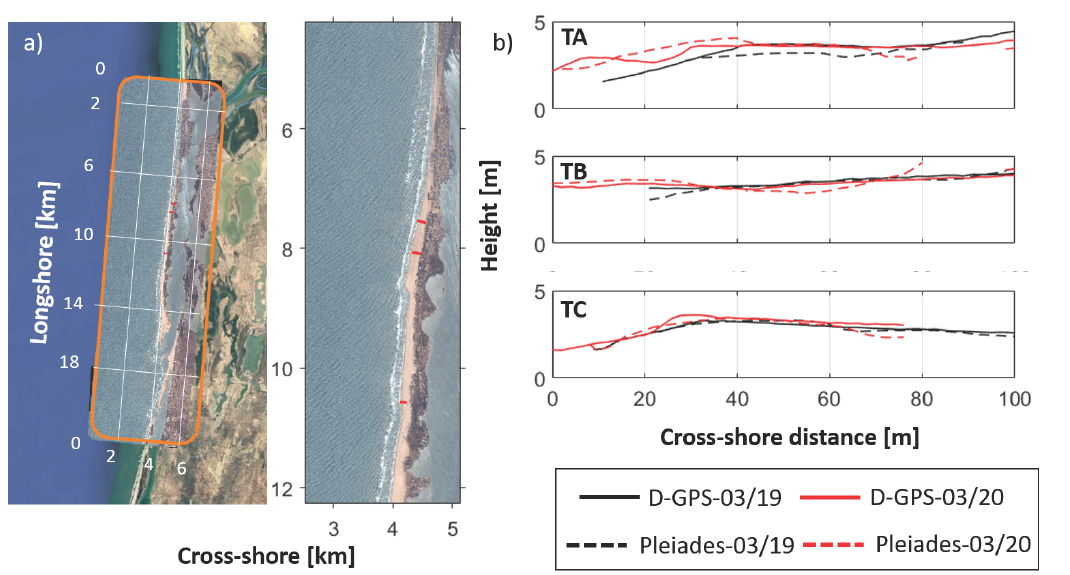
Figure 2. ( a ) Satellite image superposed from March 2019 with chosen transects for inter-comparison and zoom onto the chosen transects. ( b ) Inter-comparison (Pleiades—dashed lines, and D-GPS—continuous lines) over the chosen transects